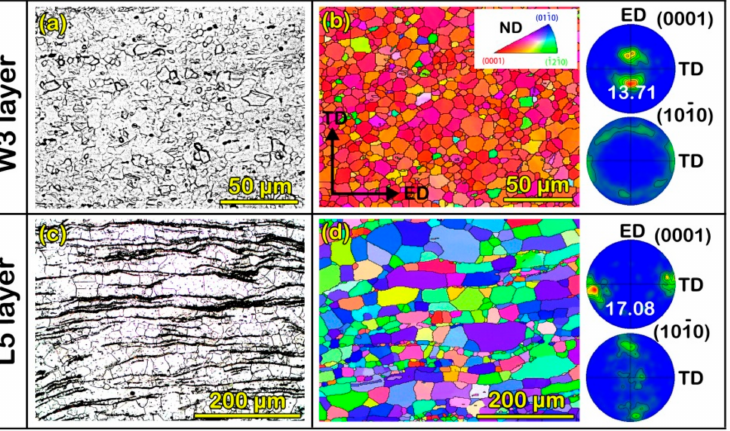
Figure 3. ( a , c ) OM images of W3 and L5 layers in W3/L5 laminated composite, respectively; ( b , d ) EBSD results including IPF and micro-texture maps of W3 and L5 layers in W3/L5 laminated composite,